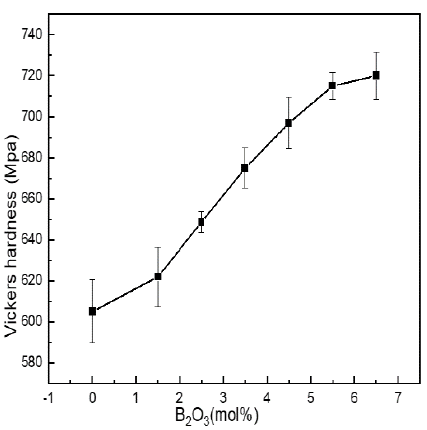
Figure 6. Change curve of mechanical properties of Li 2 O − Al 2 O 3 − SiO 2 series glass with different B 2 O 3 contents.